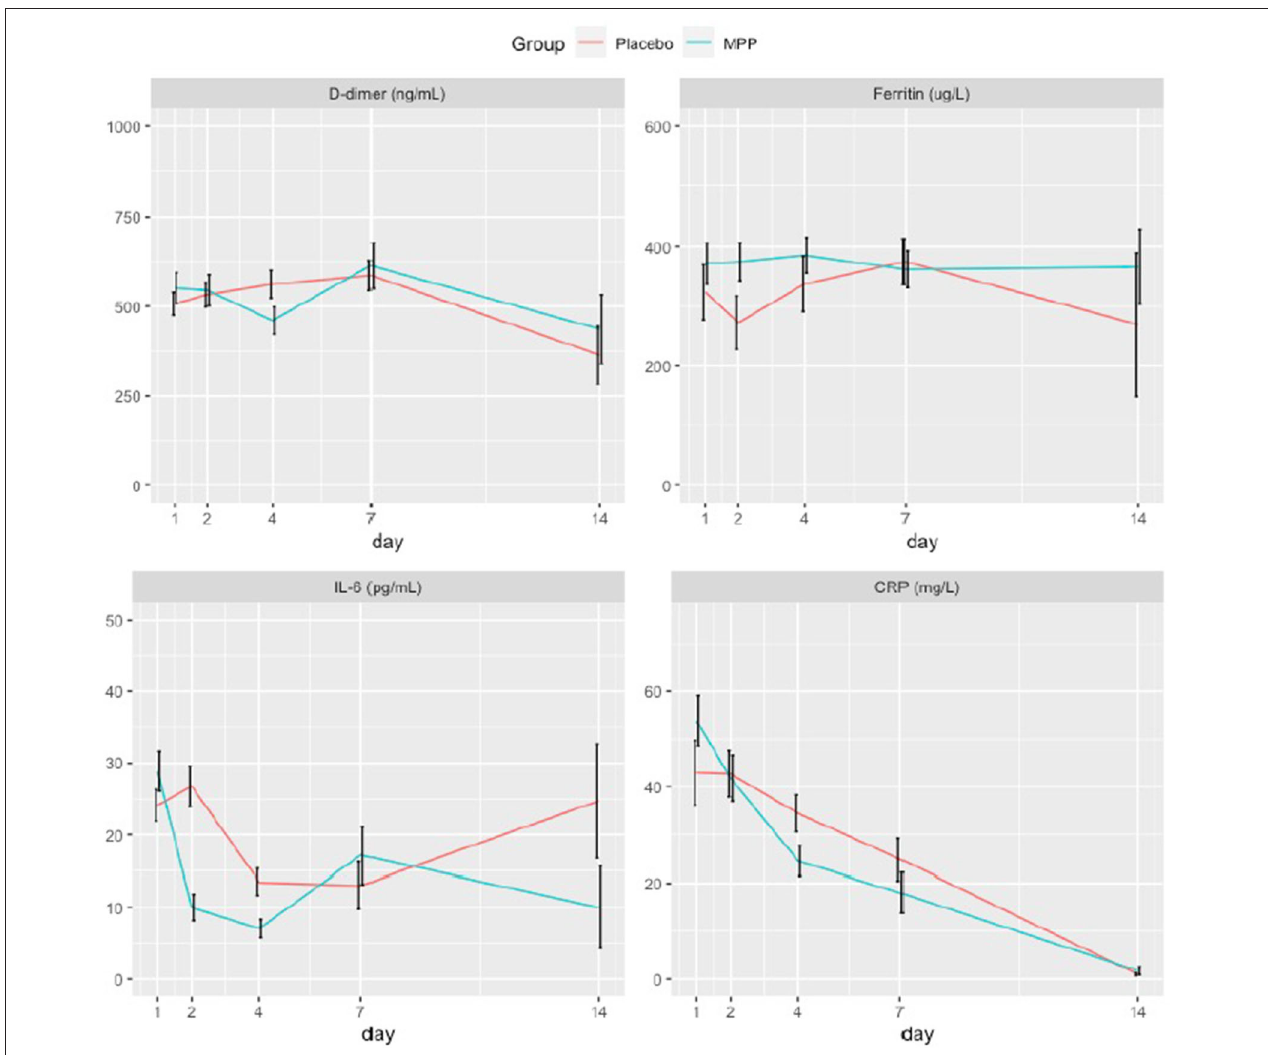
FIGURE 3 | Temporal evolution of the study participants’ inflammatory markers. These plots show the changes in the serial measurements of inflammatory laboratory parameters performed over a period of 14 days. Colored lines connect the mean value and black vertical lines indicate the confidence intervals of each measurement. Ten patients of the MPP group and another ten of the placebo group were treated with tocilizumab, a monoclonal antibody that blocks the IL-6 receptor and may cause a reactive increase in IL-6 plasma levels, within a median time of one day. MPP, methylprednisolone pulses; IL-6, interleukin-6; CRP, C-reactive